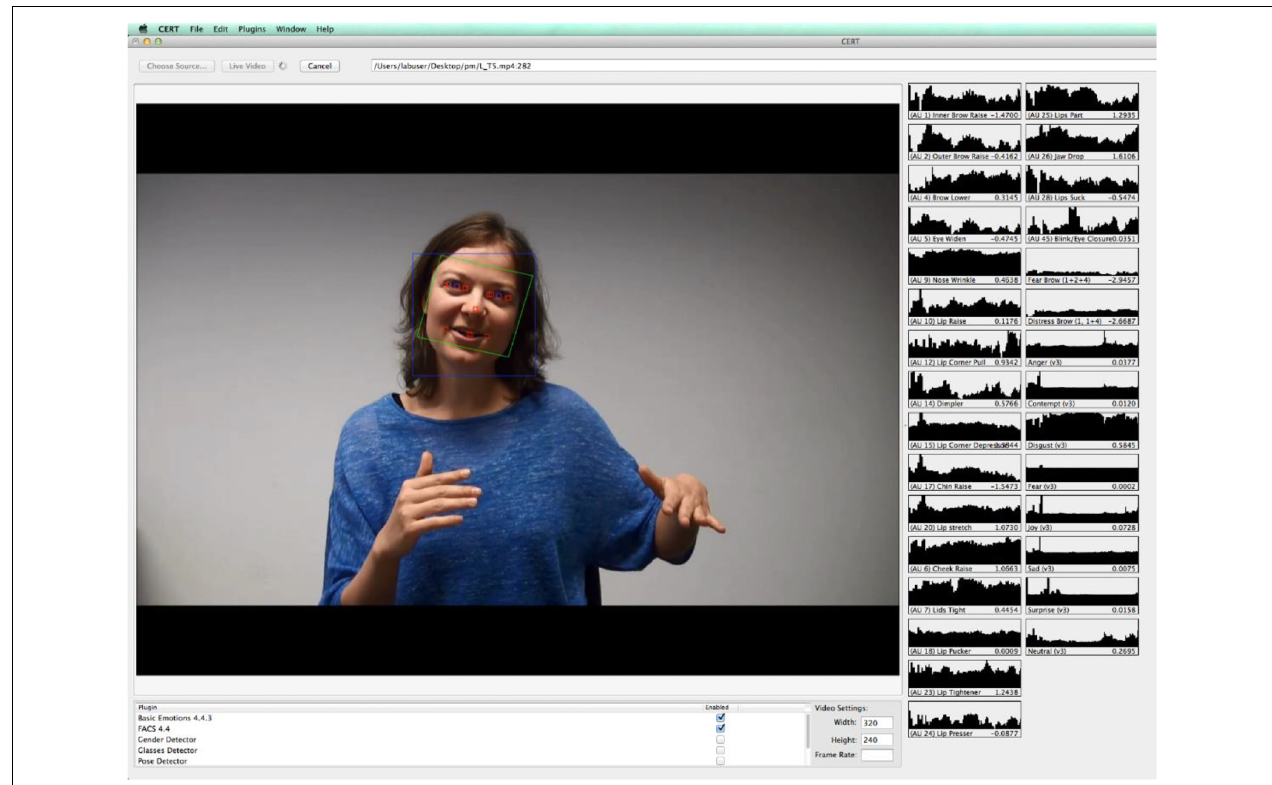
FIGURE 4 | Screenshot of CERT processing the